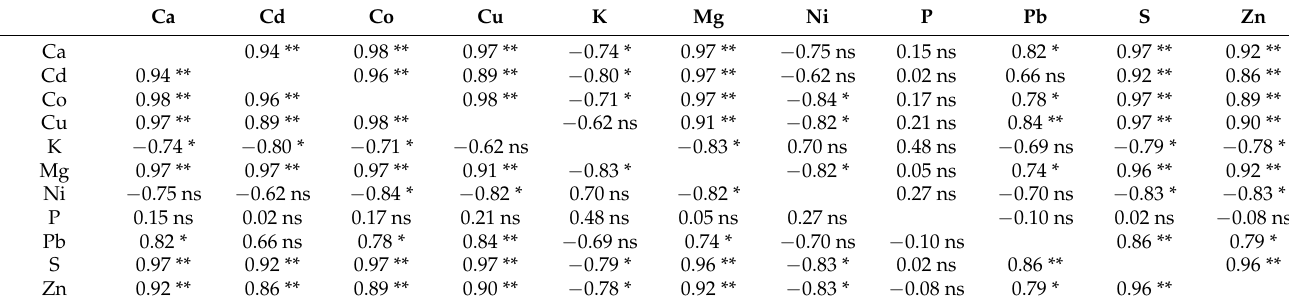
Table 4. Pearson correlation coefficients among element concentrations in the shoots of maize plants var. Naudi at the 3–4 leaf stage after 41 days of cultivation. Analysis includes both uncontaminated controls and metal-contaminated treatments. Ca Cd Co